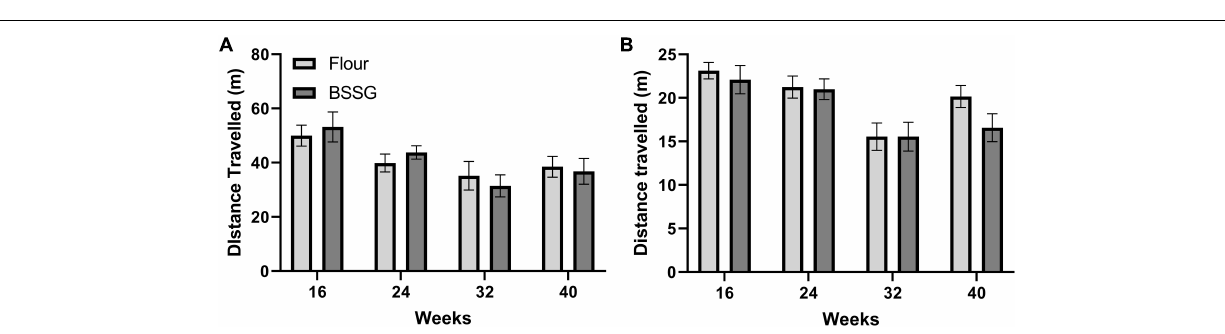
[ t (14) = 0.552, p = 0.589] ( Figure 7A ). Further, there were no group differences for Iba1 intensity in the substantia nigra at 16 weeks, [ t (18) = 1.41, p = 0.174], 24 weeks, [ t (18) = 1.20, p = 0.244], 32 weeks, [ t (17) = 0.682, p = 0.504], or 40 weeks, [ t (14) = 0.305, p = 0.765] ( Figure 7B